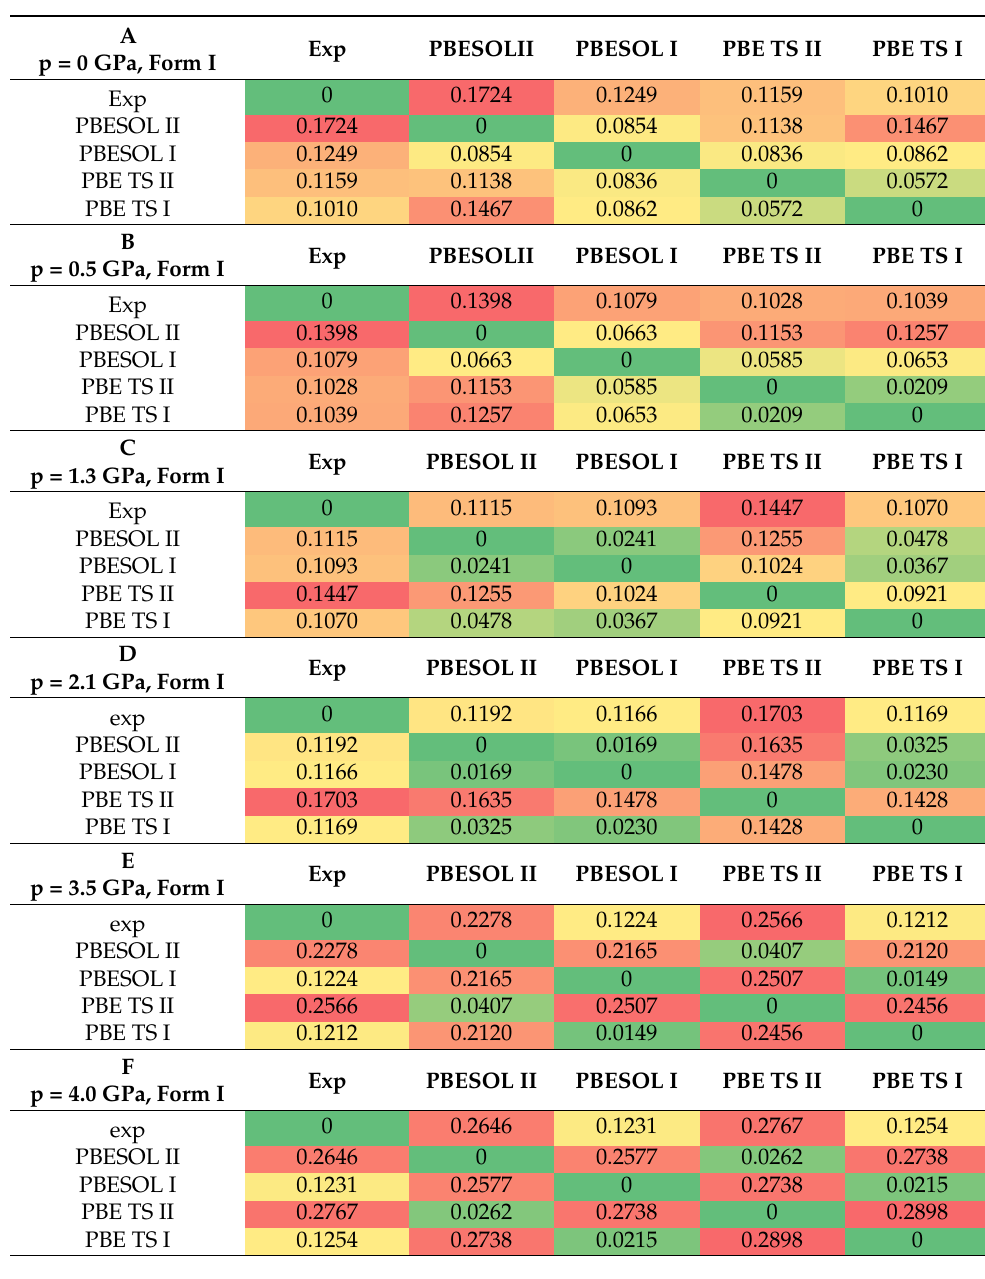
Table 2. A. RMSD of the structures at 0 GPa. B. RMSD of the structures at 0.5 GPa. C. RMSD of the structures at 1.3 GPa. D. RMSD of the structures at 2.1 GPa. E. RMSD of the structures at 3.5 GPa. F. RMSD of the structures at 4.0 GPa. G. RMSD of the structures at 4.4 GPa. H. RMSD of the structures at 5.1 GPa. I. RMSD of the structures at 5.9 GPa. To facilitate the analysis of the data in Table 2 a three-color scale was applied. In this scale, the 50th percentile (midpoint) was calculated, and the cell that holds this value was colored yellow. The cell that holds the minimum value was colored green, and the cell that holds the maximum value was colored